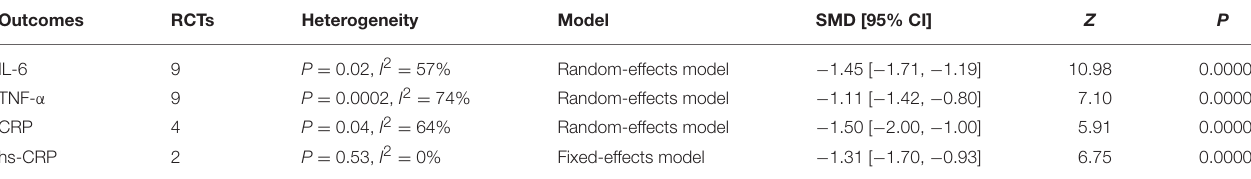
TABLE 2 | Meta-analysis of inflammation indexes.